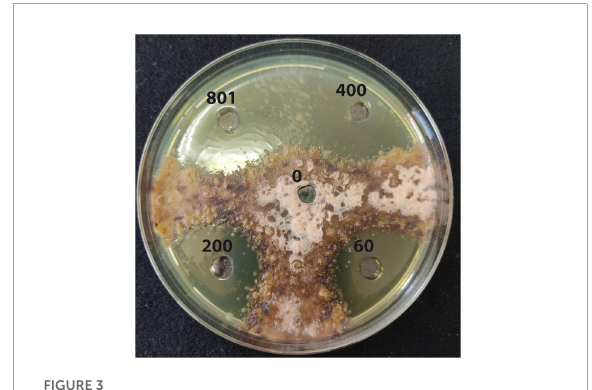
(SDW, control)–50 µ l per edge; (ii) SAP-Cu (236 mM of Cu 2 + ions)–100 mg per edge; (iii) CuSO 4 · 5H 2 O-aqueous solution